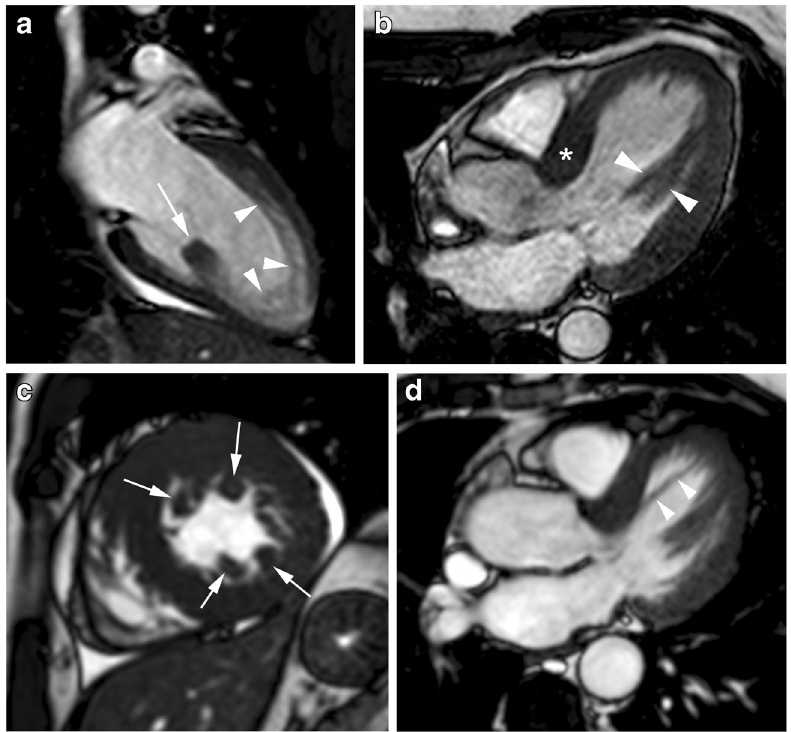
Fig. 6 Abnormalities of papillary muscles and mitral apparatus in classic HCM phenotype. a , 21-year-old woman with atypical chest and electro- cardiographic abnormalities suggestive of HCM). End-diastolic two- chamber SSFP cine MR image shows isolated posterior papillary muscle hypertrophy (arrow) and myocardial trabeculations along the anterior LV wall and apex (arrowheads); b , 45-year-old woman with asymmetric septal HCM and anomaly of papillary muscle. Horizontal long-axis SSFP cine MR image at end-diastole shows bifid anterolateral papillary